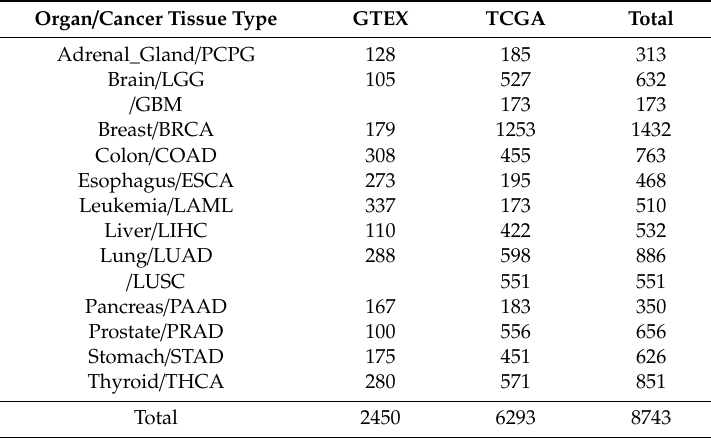
Table 1. The number of Genotype-Tissue Expression (GTEx) and The Cancer Genome Atlas (TCGA) samples used in the study 1 .